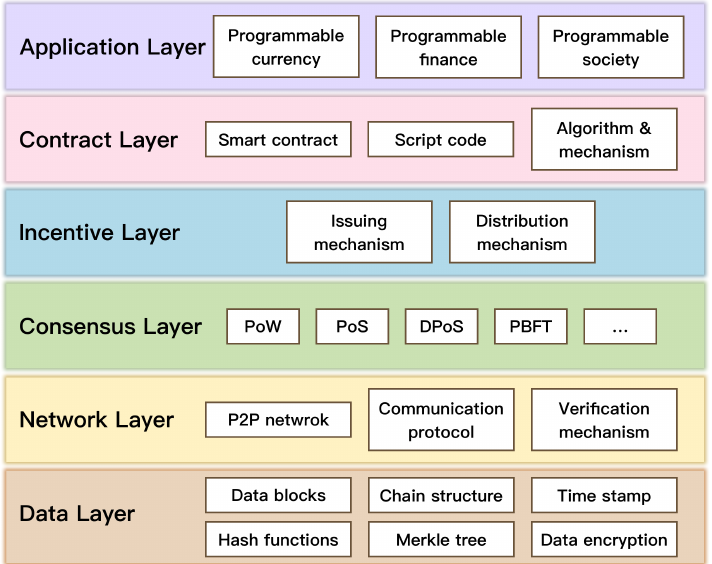
Figure 1. General architecture of